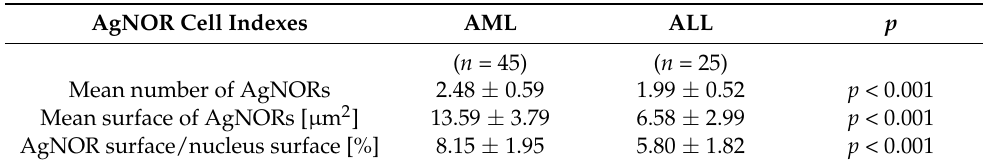
Table 1. AgNOR indexes in AML and ALL: the mean number, mean surface area, and mean ratio of AgNOR surface area to nucleus surface area, expressed as percentages in AML and ALL.